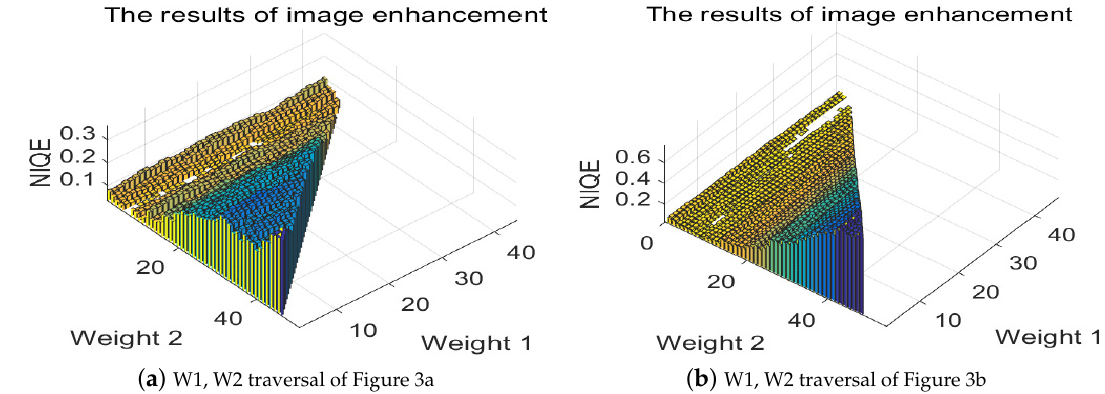
Figure 6. W1, W2 traversal